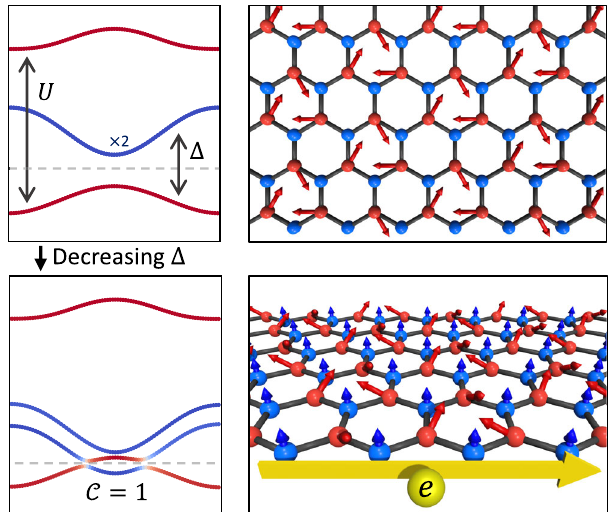
FIG. 1. Illustration of our mechanism for topological Hubbard band inversion. In the top panels, we start with a charge transfer insulator with 120° xy AFM order on the A (red) sublattice. The A quasiparticle band is split into a filled lower Hubbard band and an upper Hubbard band separated by energy U . The spin-degenerate B band lies in the Hubbard gap, resulting in a charge transfer insulator with charge transfer energy Δ . In the bottom panels, when Δ is reduced, a topological band inversion occurs. The Hubbard interaction on the B (blue) sublattice results in spin splitting of the B bands and noncoplanar spin order, as illustrated. The filled band has nontrivial Chern number and exhibits